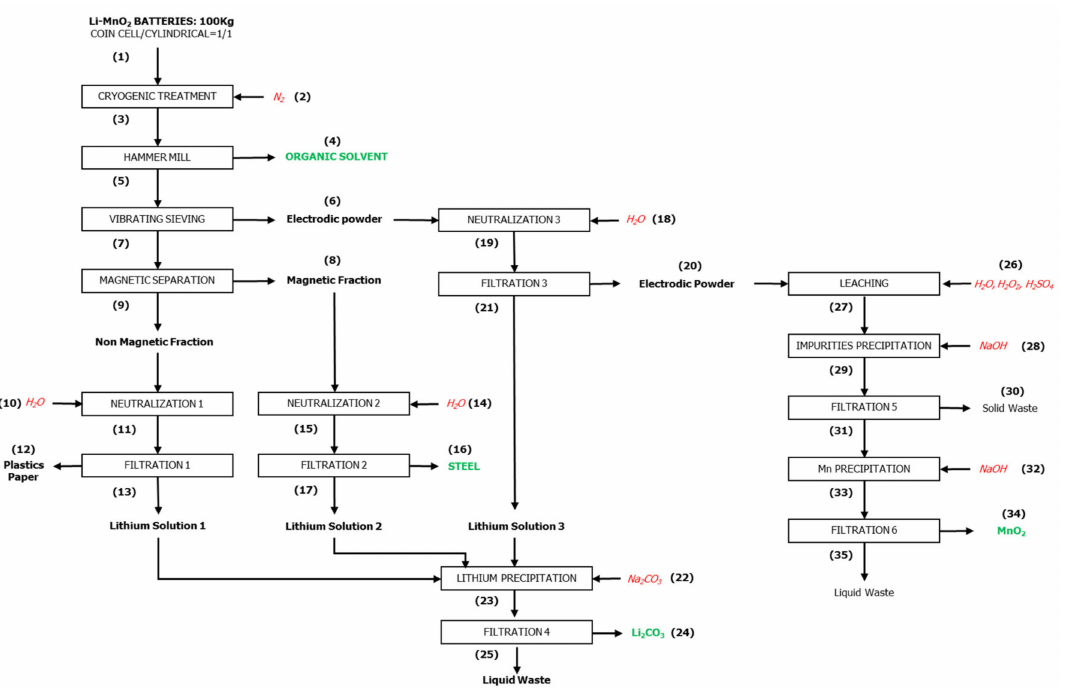
Figure 4. Block diagram for LIBAT